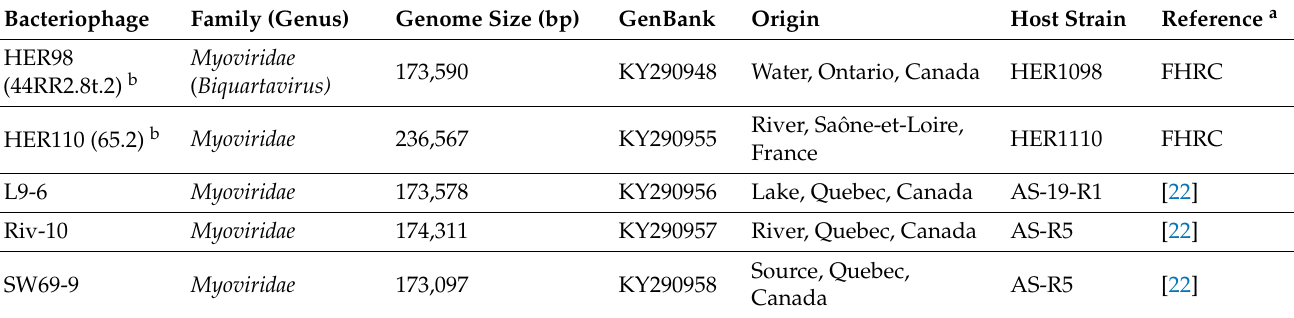
Table 2. Bacteriophages infecting A. salmonicida subsp. salmonicida used in this